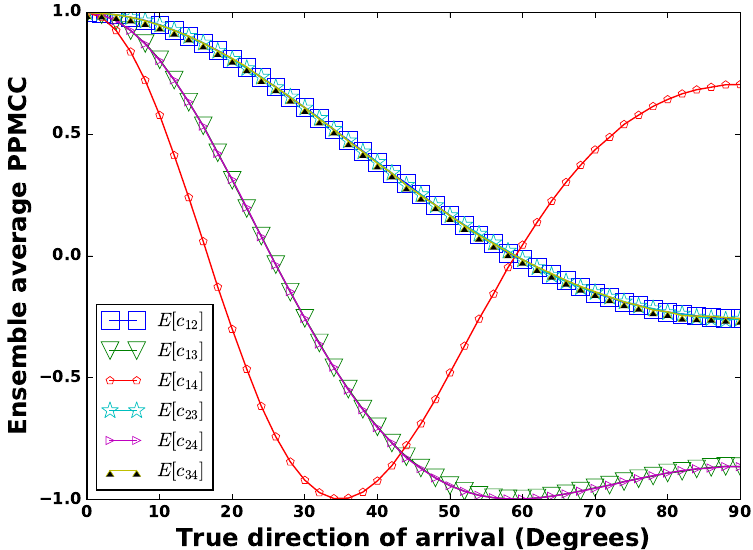
Figure 3. Ensemble average of the PPMCC versus the direction of arrival at SNR = 26